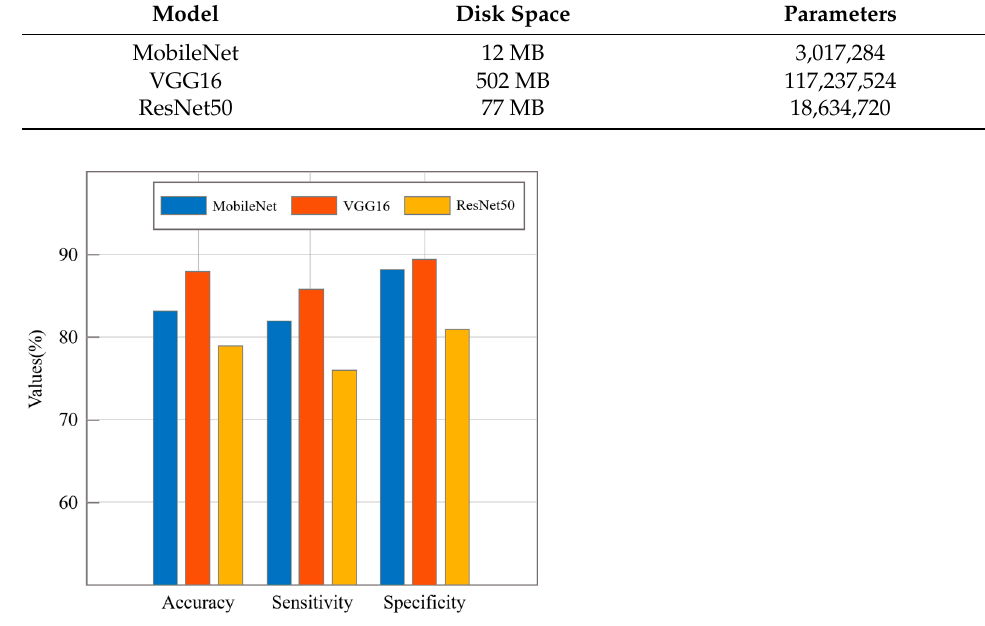
Figure 10. Comparison of the test results.